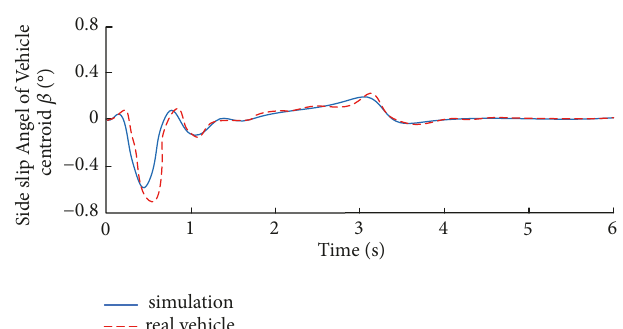
Figure 15: Side deflection curve of vehicle mass center.